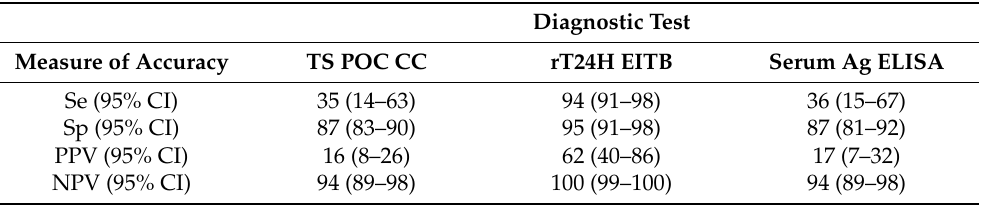
Table 3. Estimates of diagnostic accuracy.